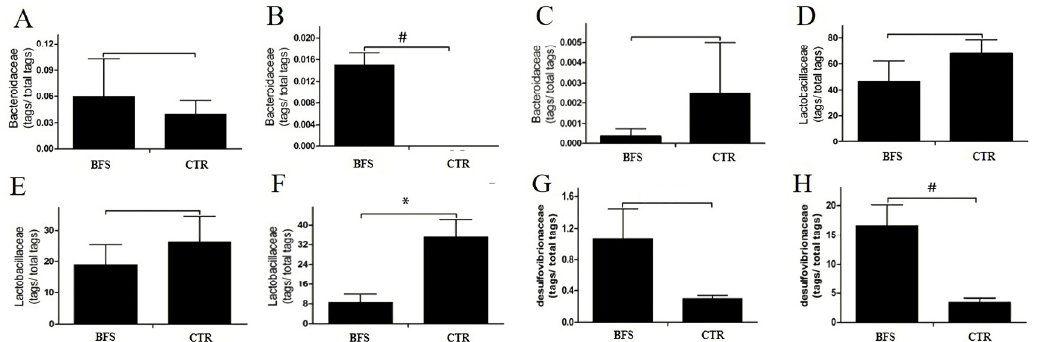
Figure 4. Flora abundance change versus time. ( A – C ): Bacteroidaceae tags/total tags ratio versus time. ( A ): Before supplementation. ( B ): At the 2nd week after supplementation. ( C ): At the 12th week after supplementation. ( D – F ): Lactobacillus tags/total tags ratio versus time. ( D ): Before supplementation. ( E ): At the 2nd week after supplementation. ( F ): At the 12th week after supplementation. ( G , H ): Desul- fovibrionaceae tags/total tags ratio versus time. ( G ): At the 2nd week after supplementation. ( H ): At the 12th week after supplementation. * p < 0.05, # p < 0.01 compared with the CTR